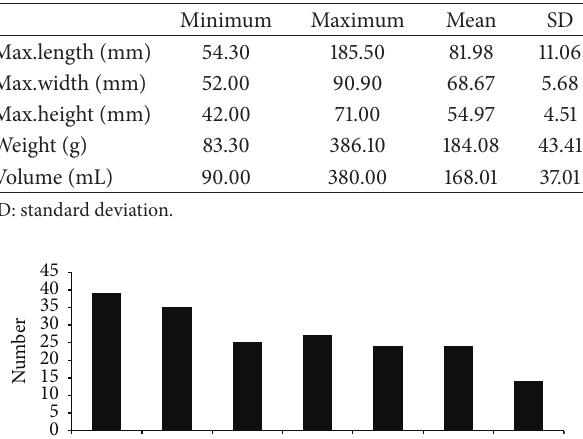
standard deviation (SD), range of weight, volume, Max.length, Max.width, and Max.height) of the potatoes.